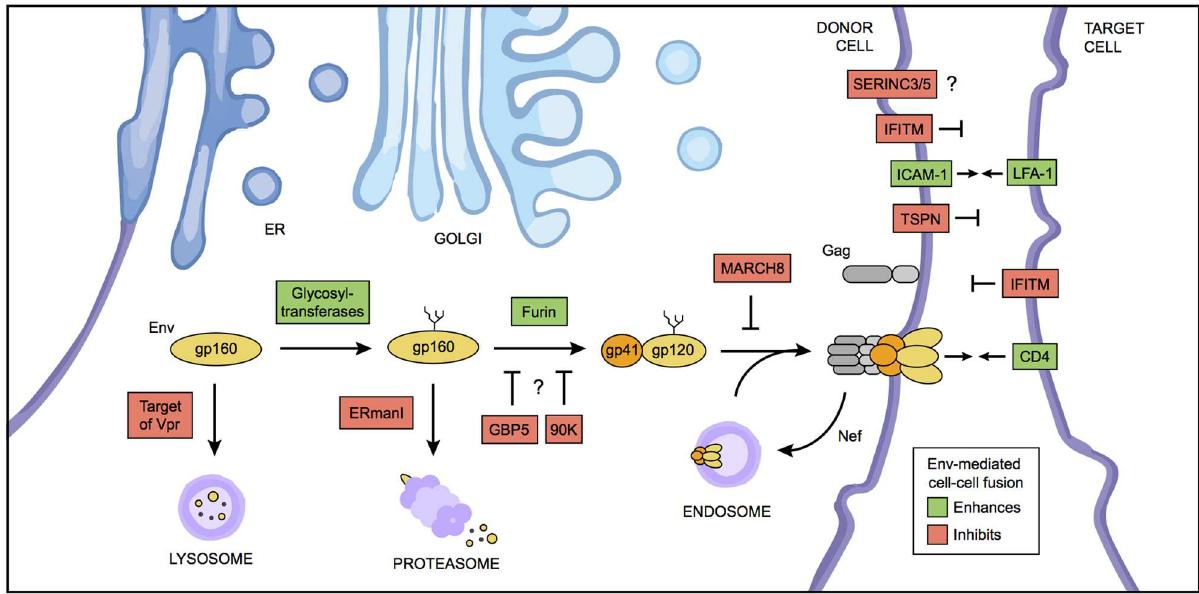
Fig 2. Host- and virus-mediated regulation of cell—cell fusion during HIV infection. A simplifiedschematic is shown of the events shapingHIV Env glycoprotein biosynthesisin the ER and Golgi and the numerous cellularfactors encountered along the way. Factors colored in green contribute positivelyto Env expression, maturation, localization, and/or direct fusogeniccapacity, while factors coloredin red are inhibitory to one or more of these processes. Arrows and blunt-endlines indicateproteins that promote or inhibit fusion, respectively, betweenthe infected (donor) cell and a neighboring target cell. Question marks are placedwhere a mechanistic understanding is lacking: GBP5 and 90K expressionboth lead to the accumulation of gp160 Env, but direct inhibitionof gp120–gp41formation has yet to be demonstrated. Similarly,it is unknownwhetherSERINC3/5 inhibits Env-mediated cell—cellfusion. TSPN, tetraspanins. IFITM, interferon- inducedtransmembrane proteins.